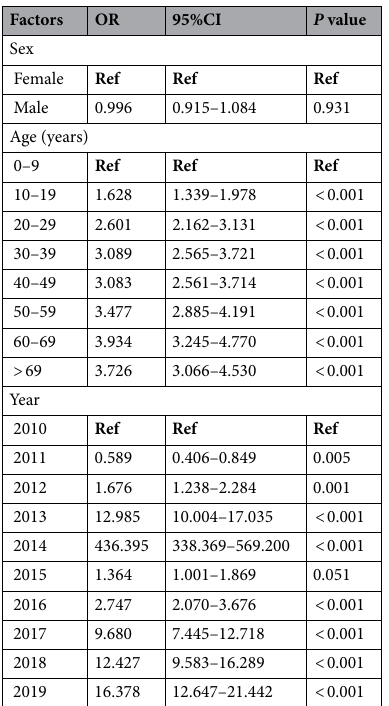
Table 2. Risk factors for dengue fever in Guangzhou from 2011–2019 at the multivariate level. CI confidence interval, OR odds ratio, Ref . reference group.